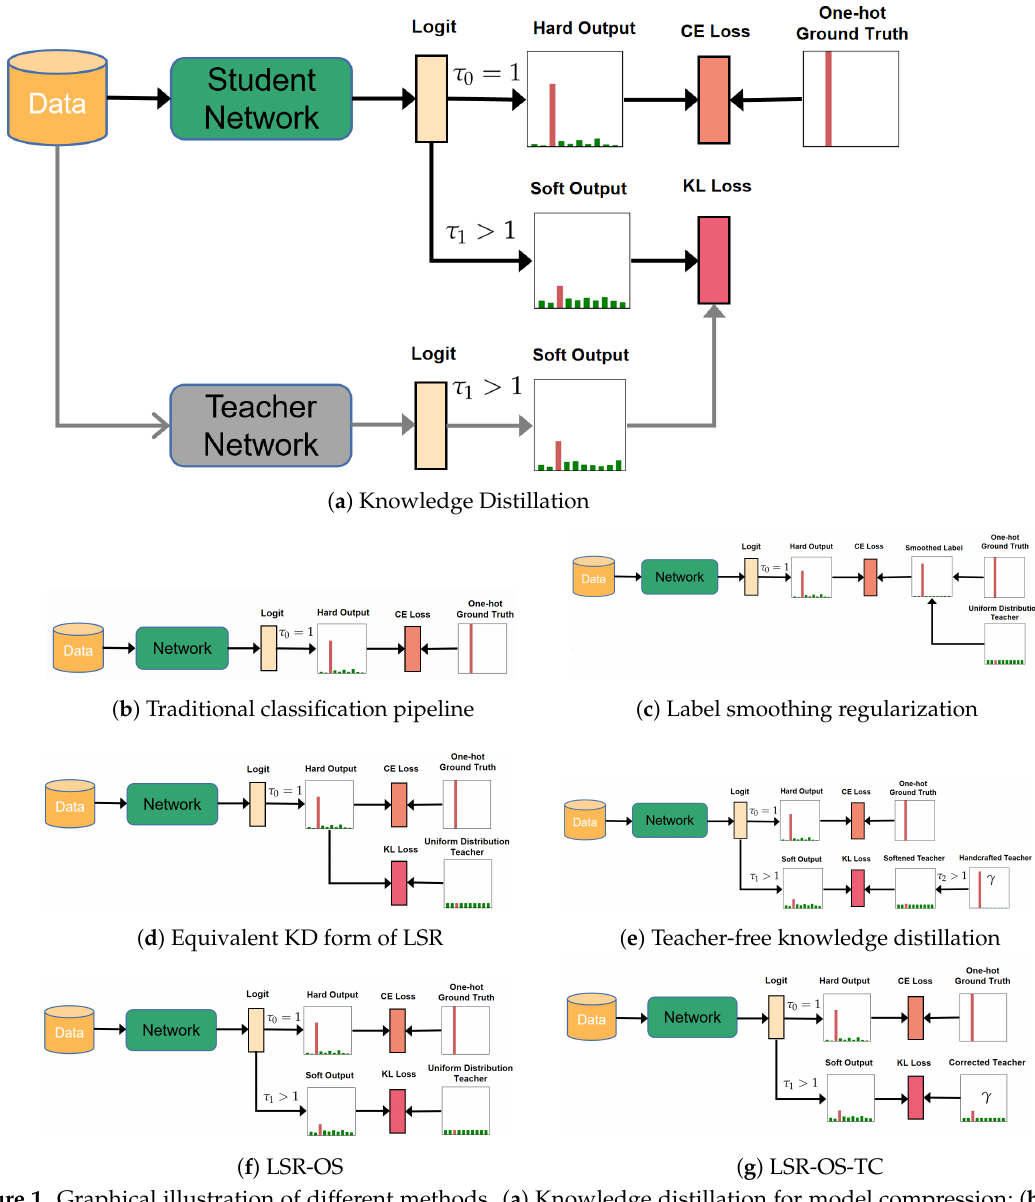
Figure 1. Graphical illustration of different methods. ( a ) Knowledge distillation for model compression; ( b ) traditional classification framework with cross-entropy loss; ( c ) label smoothing regularization; ( d ) label smoothing regularization in the KD form; ( e ) teacher-free knowledge distillation; ( f ) our proposed LSR-OS; ( g ) LSR-OS with teacher